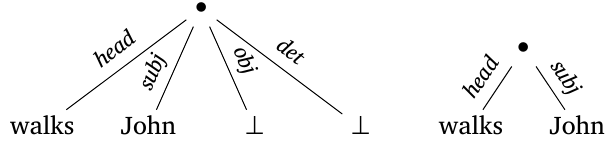
Figure 1: Tree logical structure and tree drawing